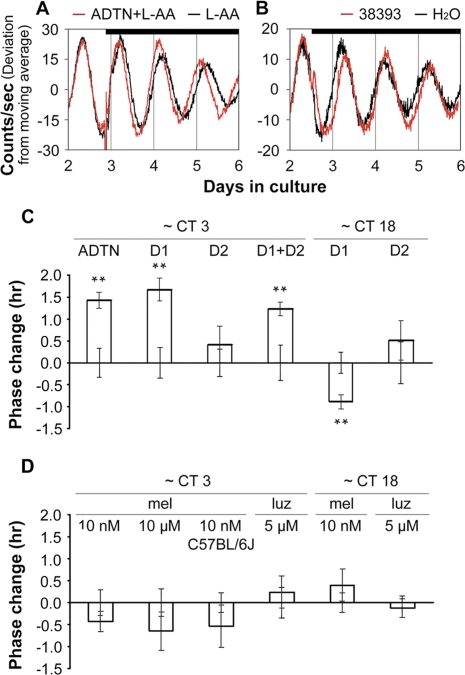
Dopamine Shifts the Phase of Retinal PER2::LUC Rhythms(A) Application of ADTN (100 μM) along with L-AA (100 μM) beginning at CT 3 advanced PER2::LUC rhythms compared to L-AA (100 μM) application alone.(B) Application of the D1 receptor agonist SKF 38393 (50 μM) beginning at CT 18 delayed PER2::LUC rhythms compared to vehicle (H2O).Data shown in (A) and (B) were baseline corrected by calculating a 24-h moving average of the raw data, and then the deviation from the moving average was plotted as a function of days in culture. Bars indicate the duration of treatment.(C) Phase change following application of dopamine agonists. Briefly, the peak times (as determined by ClockLab software) on the third cycle (after treatment) were subtracted from the peak times on the second cycle (before treatment) for both drug and vehicle, and then used to calculate the phase change of drug versus vehicle controls. Bars show drug phase changes (means ± SEM), error bars from x axis show ±SEM for vehicle controls in each group. Drug concentrations were as follows: ADTN, 100 μM; the D1 agonist SKF 38393, 50 μM; and the D2 agonist quinpirole, 50 μM. Double asterisks (**) indicate p < 0.01, Student's t-test; n = at least 4 for each drug treatment and for vehicle controls.(D) Lack of phase change following application of melatonin reagents. Phase change was calculated as in (C). Drug concentrations are indicated above columns. Vehicles used for 10 nM melatonin (mel), 10 μM melatonin, and 5 μM luzindole (luz) were 1 μl of 0.01% ethanol, 1 μl of 10% ethanol, and 1 μl of DMSO, respectively; n = at least 4 for each drug treatment and for vehicle controls. No significant effects were observed (p > 0.05 for all).